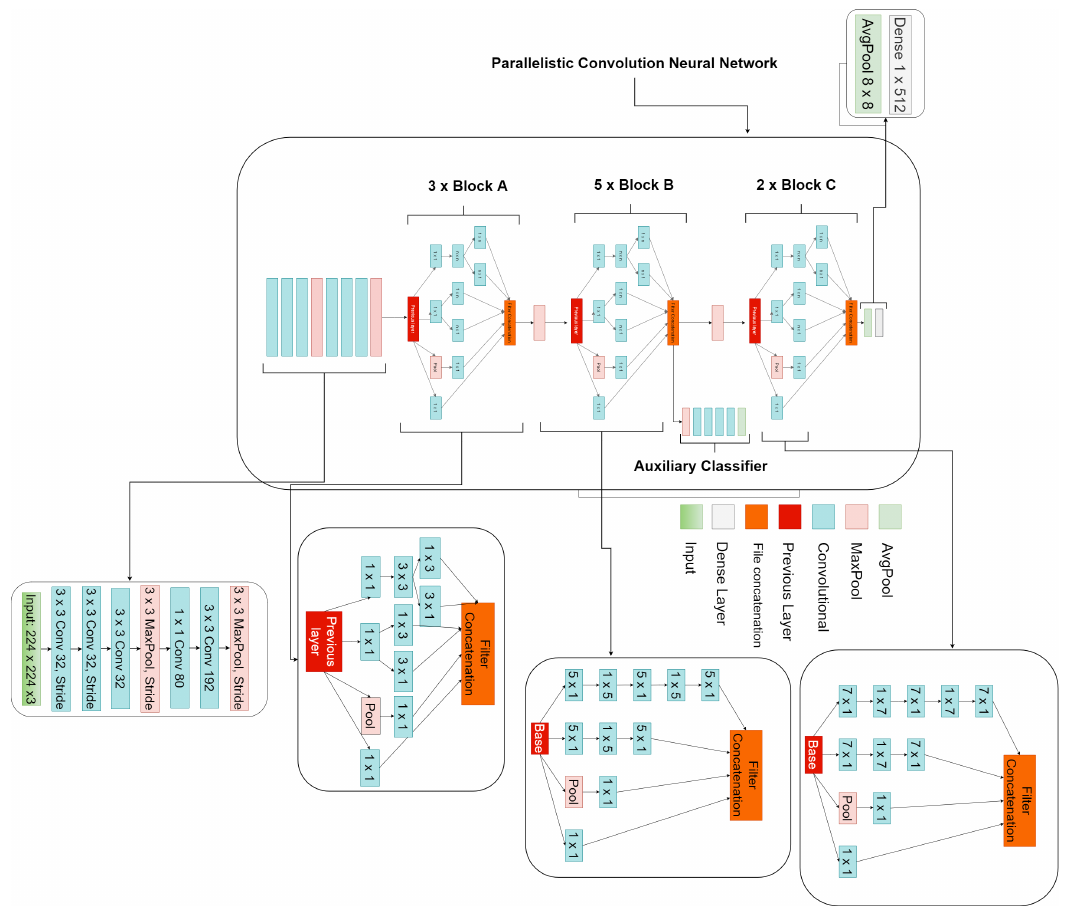
Figure 3. Framework of the proposed parallelistic convolution neural